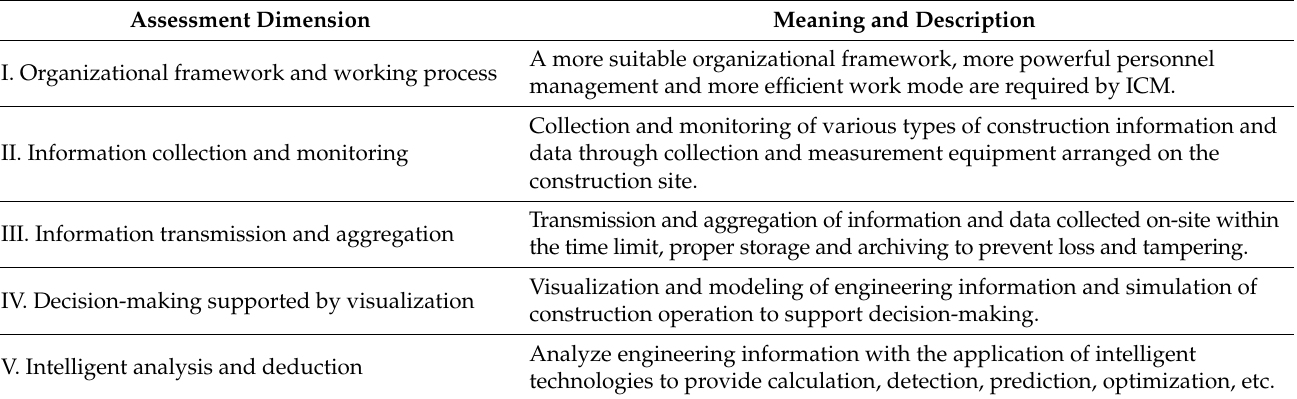
Table 4. Meaning and description of each assessment